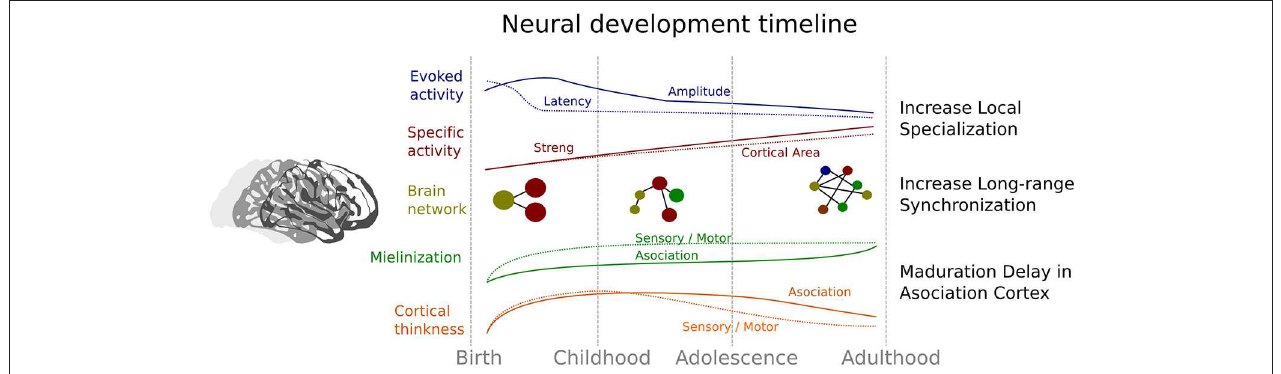
FIGURE 2 | Summary of the neural evidence related to the developmental trajectory of the social brain. Blue indicates changes related to event-related potential evidence; Red denotes changes associated with the brain activity related to specific social tasks. Continuous line represents the strength in association between brain activity and social tasks, and dotted line indicates the areas of brain that show significant activity. Yellow represents the change in connectivity and architecture of the brain networks. Green represents changes in myelination and orange changes in cortical thickness in both sensory-motor areas (dotted lines) and association areas (continuous